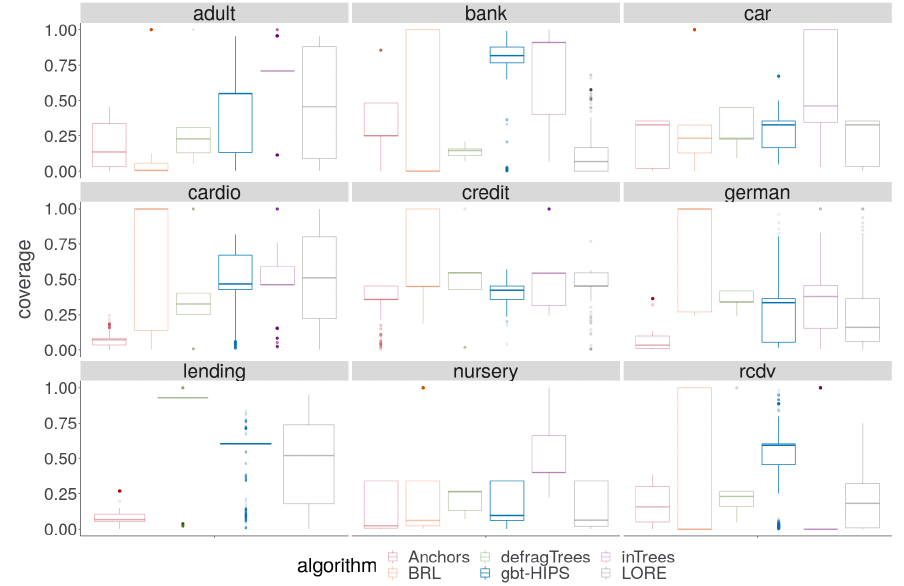
Figure 3. Distribution of coverage for stochastic GBT model explanations.